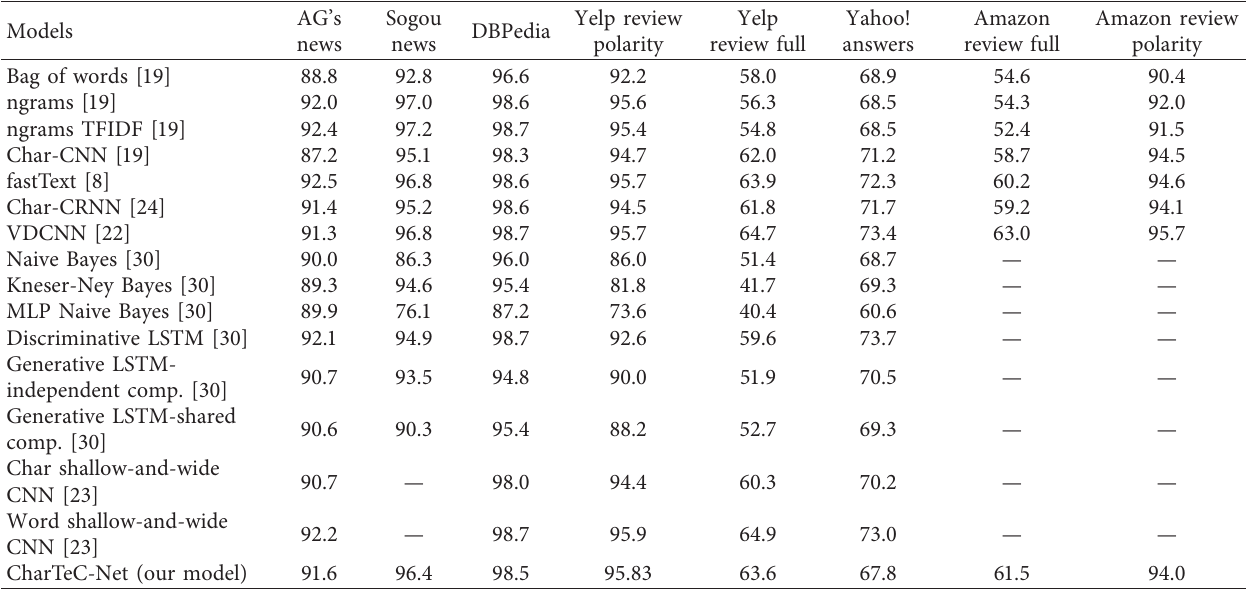
Table 2: Accuracy results for all the models. Numbers are in percentage.